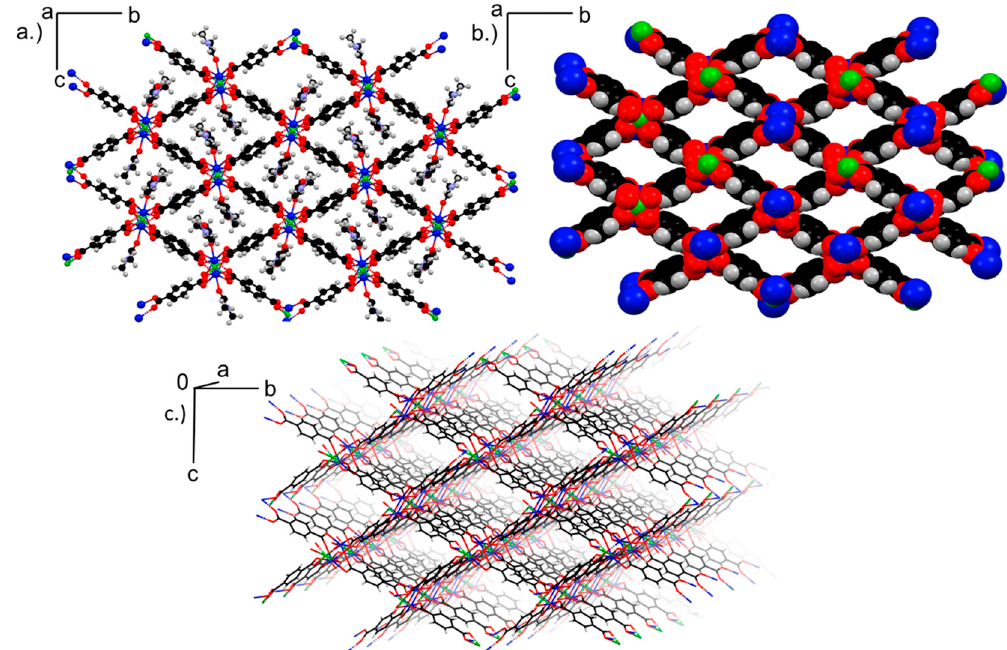
Figure 3 . The extended view along the a-axis of compound 1 , with ( a ) showing the DMF present in the pores, ( b ) showing the DMF removed with a space-filled view, and ( c ) showing a perspective view highlighting the 1-D channels. The colors for elements are as follows: gadolinium (blue), copper (green) oxygen (red), carbon (black), nitrogen (purple), hydrogen (white).